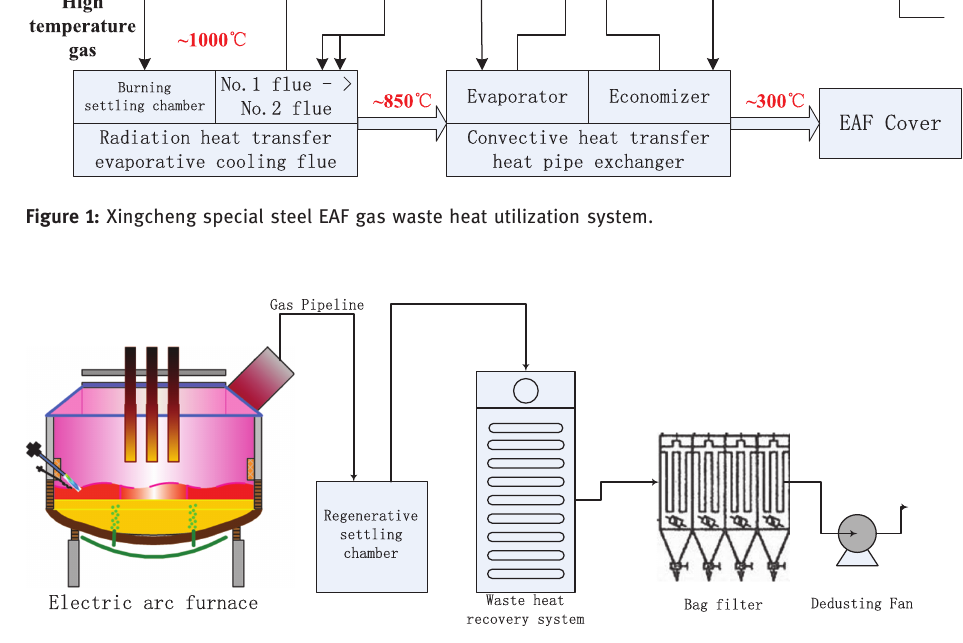
Figure 2: Flow chart of the dust abatement and residual heat recovery